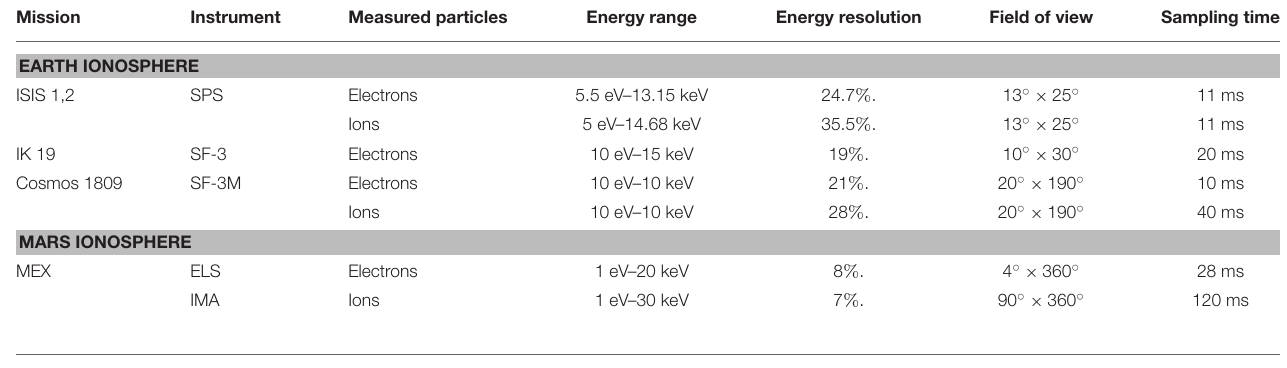
TABLE 2 | Sounders used in SAP studies.